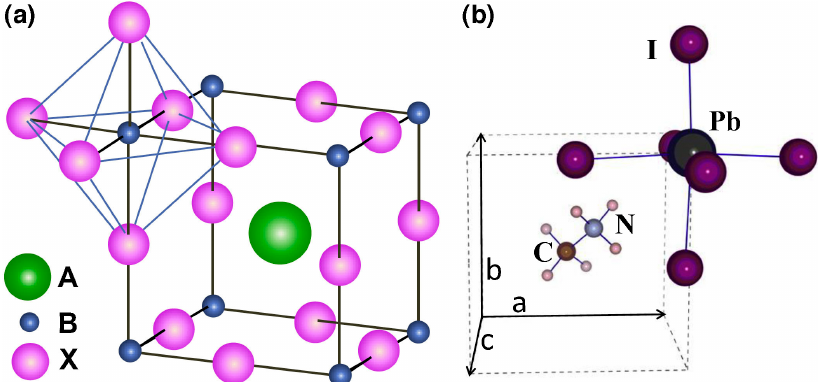
Figure 1. ( a ) ABX 3 perovskite structure showing the BX 6 octahedral and larger A cation occupied in the cubo-octahedral site; ( b ) unit cell of cubic CH 3 NH 3 PbI 3 perovskite (reproduced with